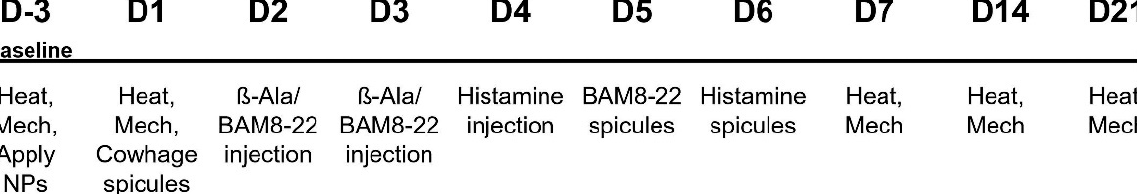
Figure 10. Timeline for human testing. Thresholds for warmth, painful heat and to mechanical stimuli (Mech) were obtained at the test site on each arm prior to application of blank and capsaicin NPs on Day 3 and again after NP removal four days later (D1) and again on D7, 14 and 21. Sensory ratings to cowhage spicules on D1, and to injection of β -alanine ( β -Ala), BAM8-22 and histamine as indicated and subsequently to application in heat-inactivated spicules containing BAM8-22 and to histamine.